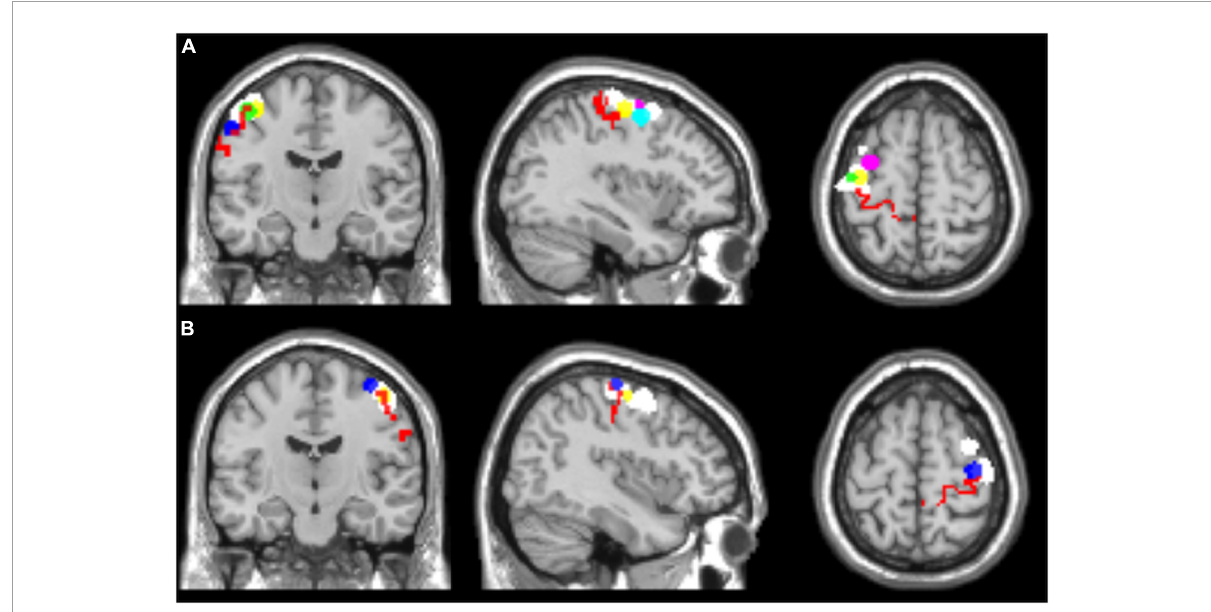
FIGURE1 Regions of interest selected for seed-based functional connectivity analyses, overlaid on a T1 single-subject template. (A) Left hemisphere, (B) right hemisphere. l-BA4 and r-BA4 are shown in red; the other ROIs are differently colored to represent the individual seed regions based on the hand motor hotspots detected by TMS (l-hMHS and r-hMHS). Please note that some of the ROIs might be